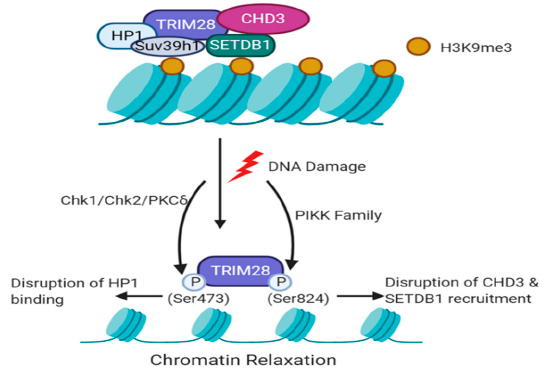
Figure 2. TRIM28 phosphorylation at double-strand breaks (DSBs) . TRIM28 forms a repressive complex with HP1 and methyltransferase Suv39h1 at heterochromatic H3K9me3 marks. In addition, TRIM28 also associates with the chromatin remodeller CHD3 and SETDB1 methyltransferase. Upon DNA damage, TRIM28 is phosphorylated at Ser473 by Chk1, Chk2 or PKC δ kinases, or at Ser824 by members of the PIKK family. TRIM28-Ser473 phosphorylation disrupts its binding to HP1 family proteins, inhibiting its transcriptional repressive activities. TRIM28-Ser824 phosphorylation disrupts the recruitment of CHD3 and SETDB1, promoting chromatin relaxation to facilitate the access of DNA repair factors.